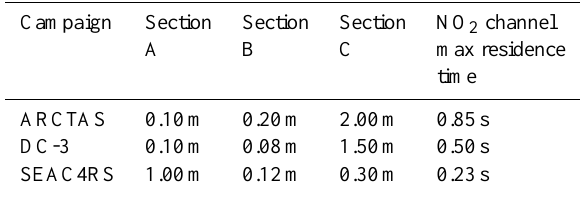
Table 1. Lengths for tubing in the corresponding sections for Fig. 3. Campaign Section